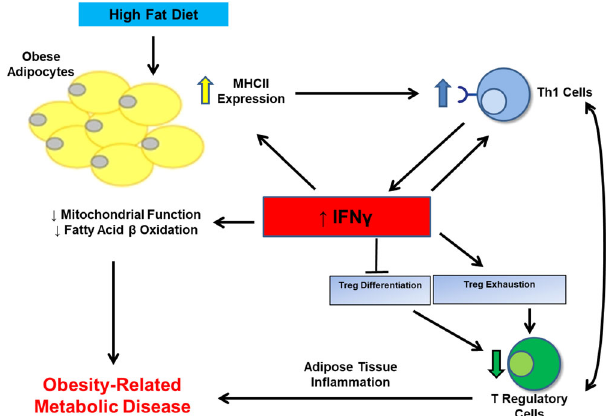
Fig. 6 | Summary of the proposed mechanism for adipocyte-mediated insulin resistanceinhumanobesity,illustratingthecentralroleofinterferongamma. Obese adipocytes acquire increased antigen presenting capability leading to an increaseinCD4+Th1cellsinATthatproduceIFN γ .IncreasedIFN γ suppressesTreg differentiationandenhancesTregexhaustion,augmentsadipocyteMHCIIpathway which is not common to other cytokines, and attenuates adipocyte mitochondrial functionandfattyacid fl uxtocreateanescalatingcycleofin fl ammationandinsulin resistance. Exhaustion features in human Tregs include increased expression of inhibitory co-receptors and markers of apoptosis and suppressed